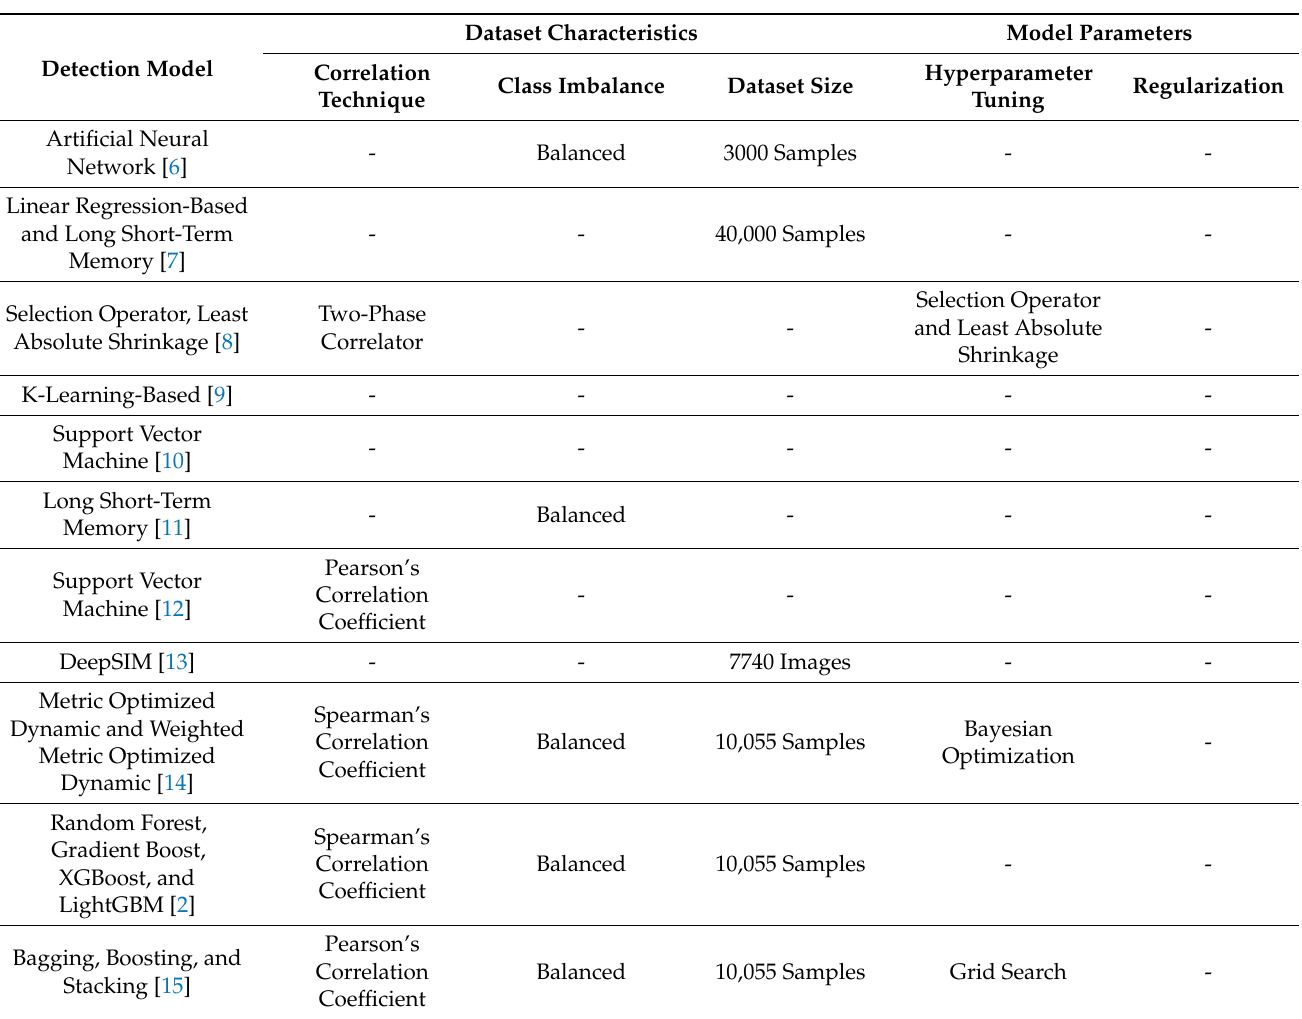
Table 1. Comparison of existing machine learning techniques with respect to dataset characteristics and model